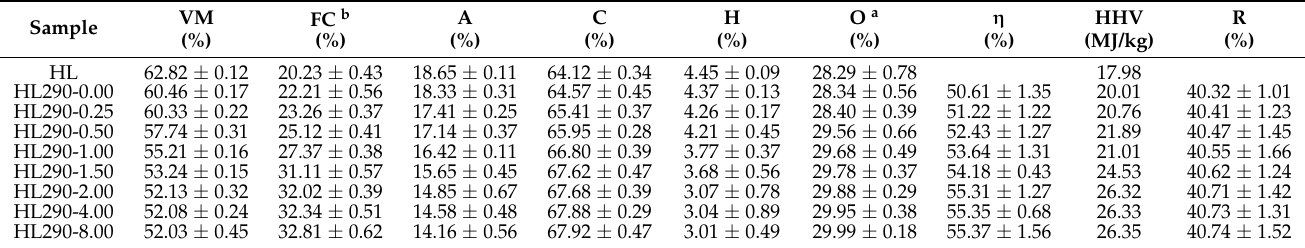
Table 1. Chemical characteristics of lignin and hydrochar obtained at different holding times and energy recovery efficiency of hydrothermal